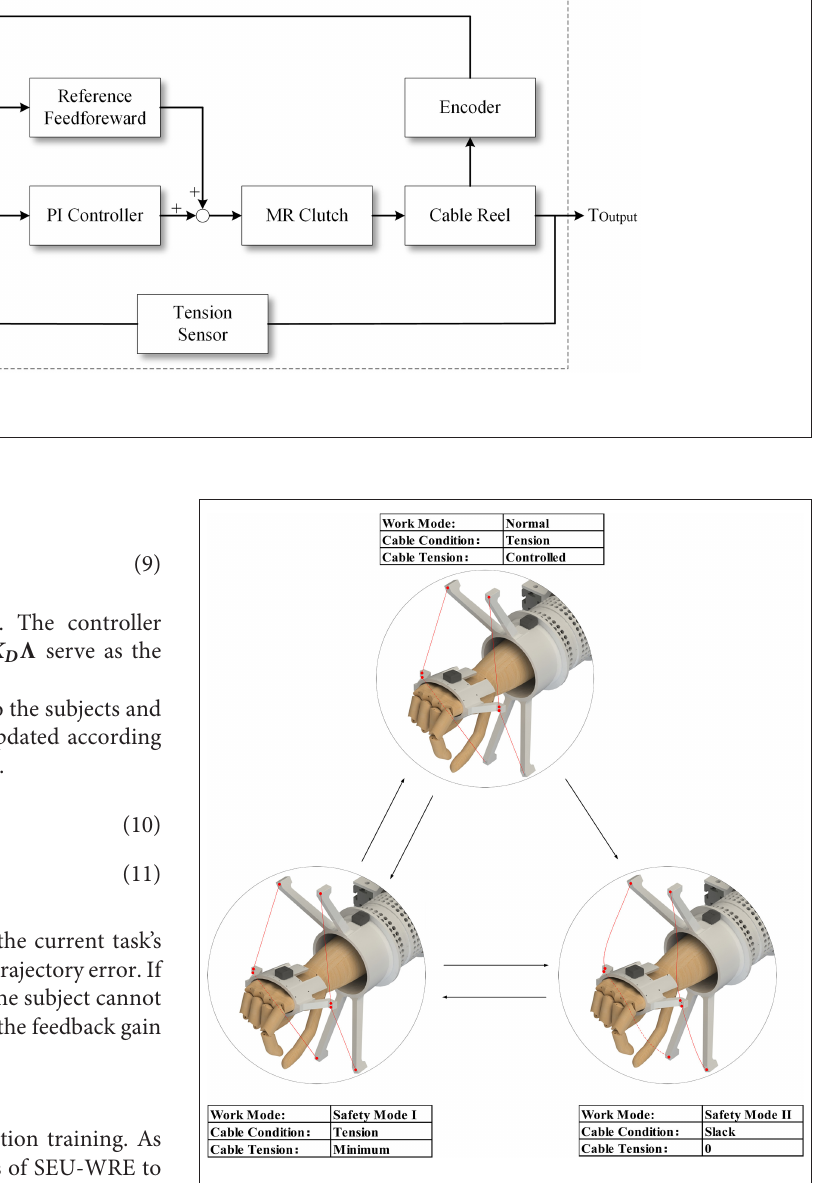
FIGURE 7 | Three work modes for